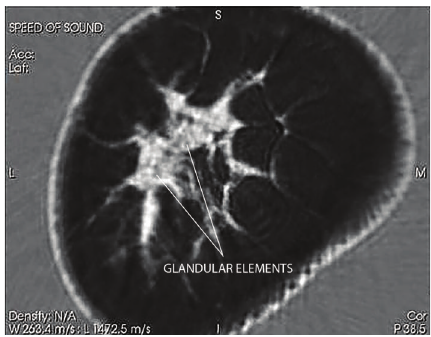
Figure 7: The transmission (speed of sound) coronal image is able to differentiate between glandular elements (speed values 1517–1567 m/s) from ductal tissue elements (speed values 1560– 1612m/s) in dense breast tissue as shown here in a moderately dense cadaver breast. The “stippled” appearance of the high magnification speed images differentiates the glands (grey) from the ductal and connective tissue elements.